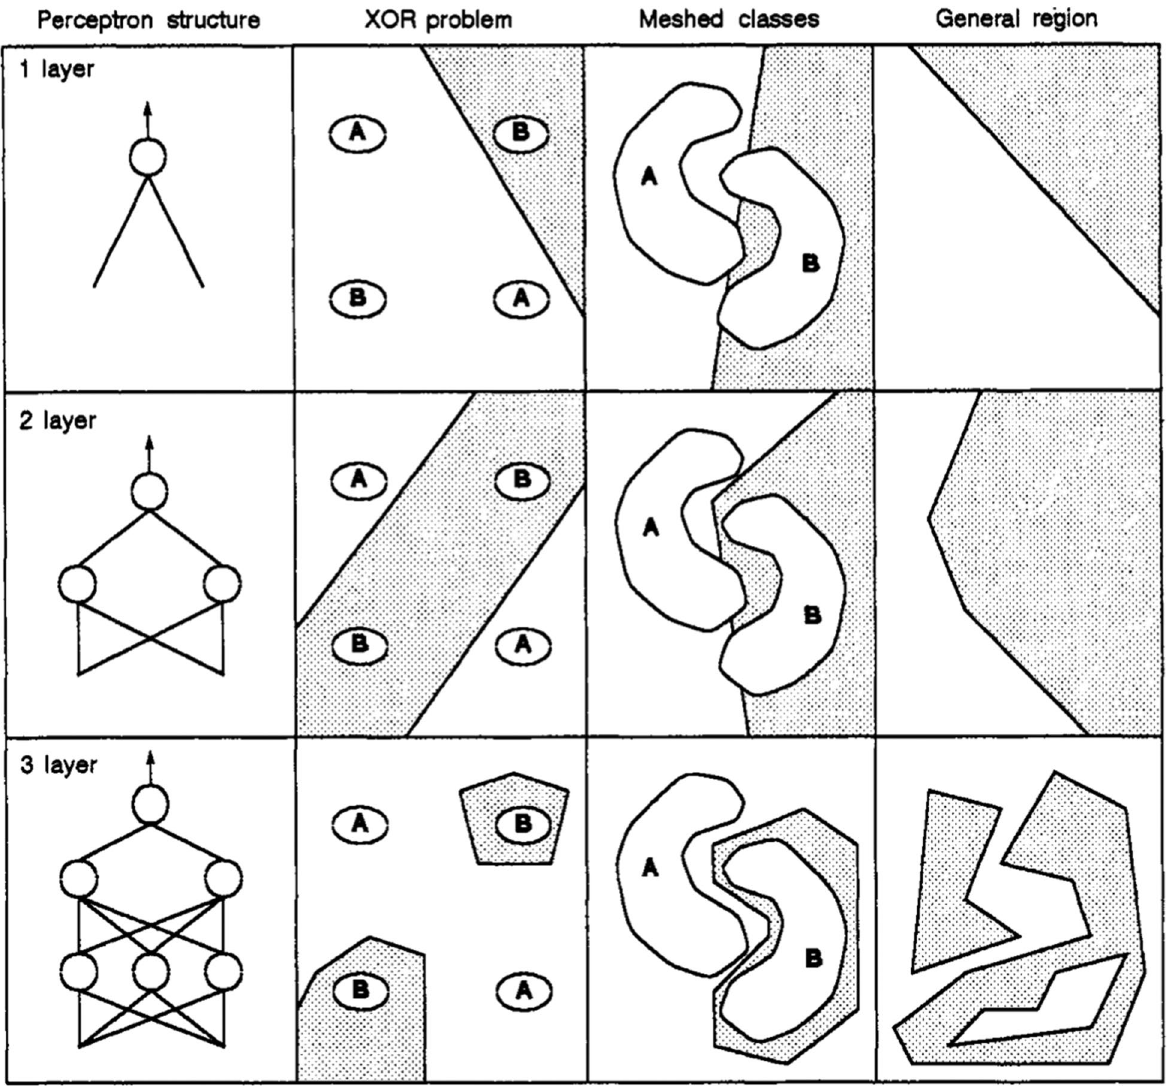
Fig. 7 Possible regions for MLPs (from [76]); given the extreme complexity of regions in most ANN applications, many layers are needed (three are shown here). The challenge of partitioning for complex spaces is illustrated for simple cases of handling targets that distribute in non-convex ways. The middle column poses a case of two classes (A, B) that are not contiguous, and the next column theorizes a case where classes A and B may have more arbitrary shapes, blocking simple classification. Possible class regions are shown and shaded or